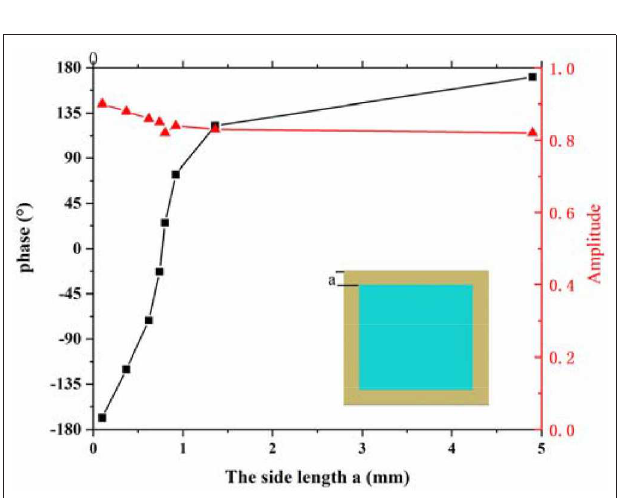
FIGURE 2 | The amplitudes (red triangle dots) and reflection phase shift (black square dots) of a metasurface with different side lengths at 19.6 GHz